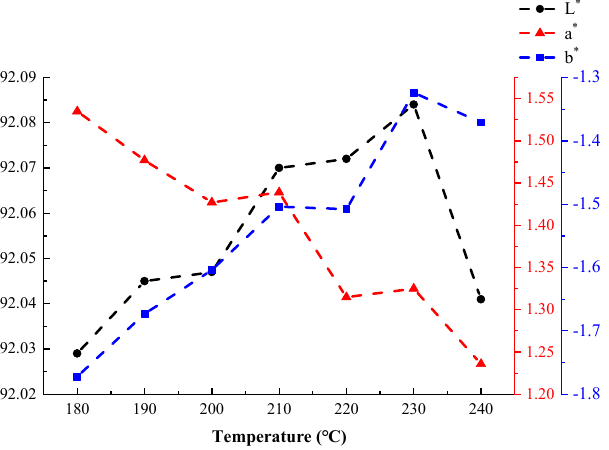
Figure 14. The effects of temperature on the coatings’ CIE laboratory color model values. Summary